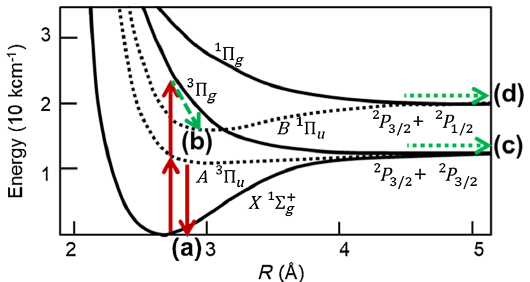
FIG. 1. The relevant potential energy levels in I 2 , together with the nonlinear processes observed in this experiment. (a) Impulsive simulated Raman scattering. (b) Spontaneous hyper-Raman scattering. (c),(d) Dissociation following two-photon